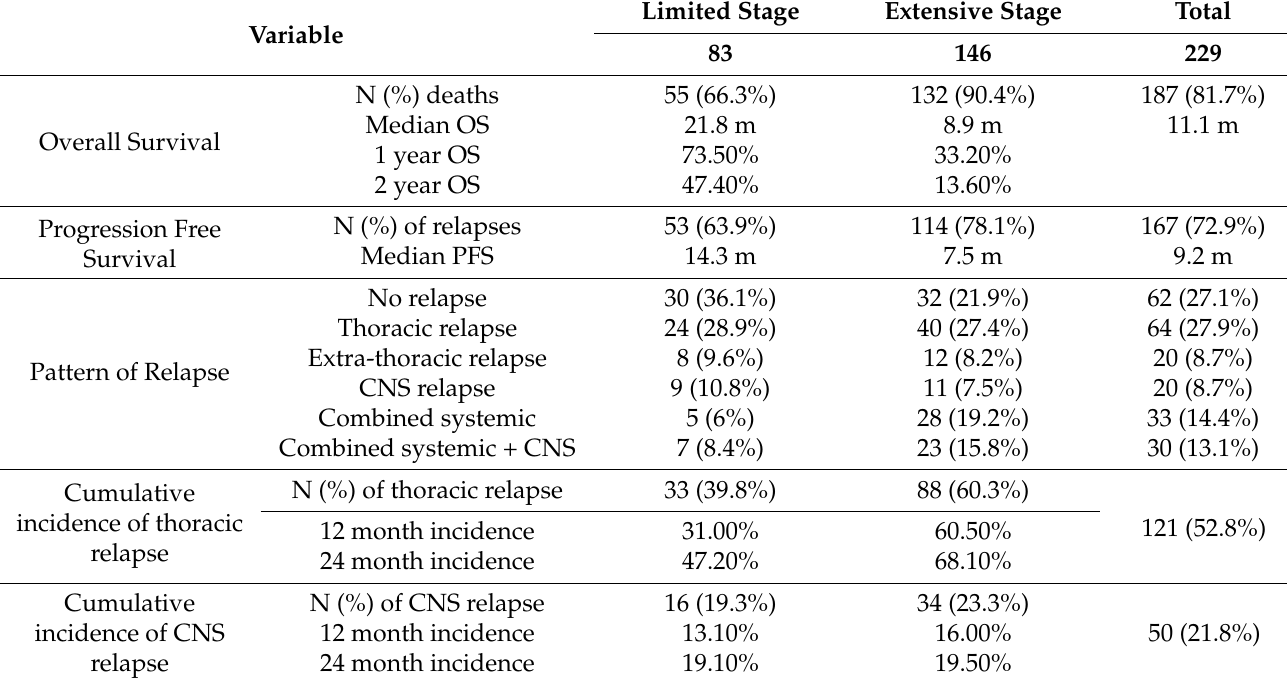
Table 4. Patterns of relapse and outcomes of treatment.